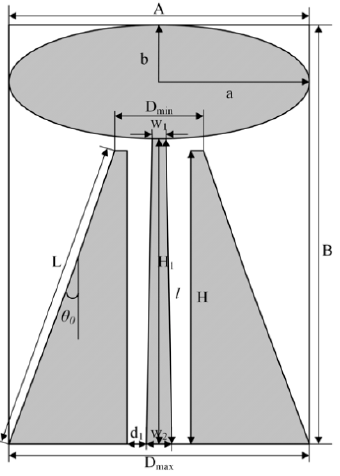
Figure 7. Structure diagram of elliptic monopole antenna.